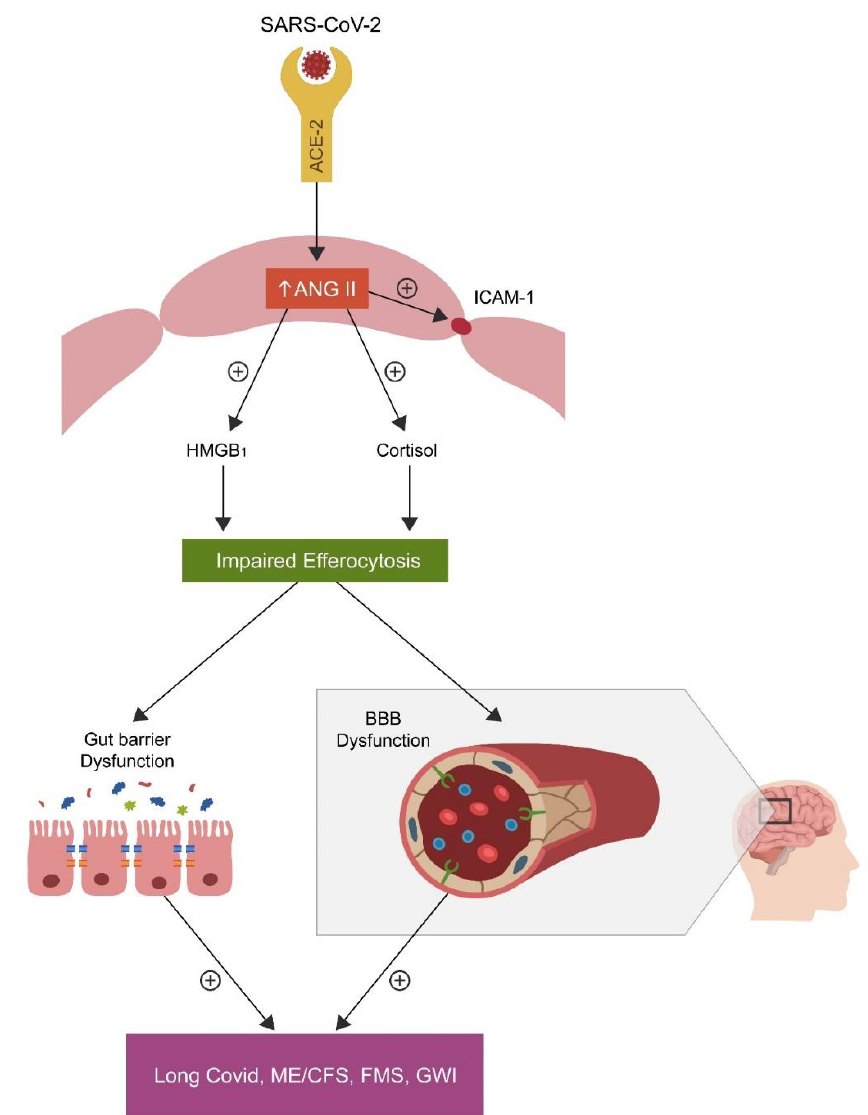
Figure 2. SARS-CoV-2 attachment to ACE-2, blocks this enzyme, causing angiotensin II (ANG II) accumulation by inhibiting its hydrolysis. Upregulated ANG II, increases both cortisol and HMGB1, disrupting the efferocytosis of senescent cells. Accumulation of senescent cells triggers inflammation and biological barrier disruption, a common pathology found not only in the disorders marked by chronic fatigue but also in neuropsychiatric and autoimmune diseases.